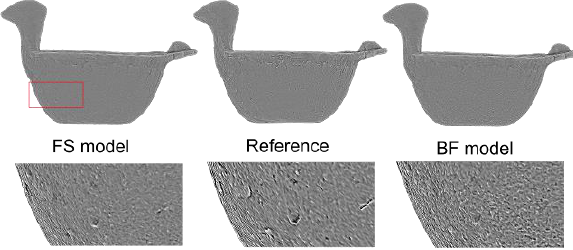
Figure 8: Subjective comparison of noise levels between FS, BF